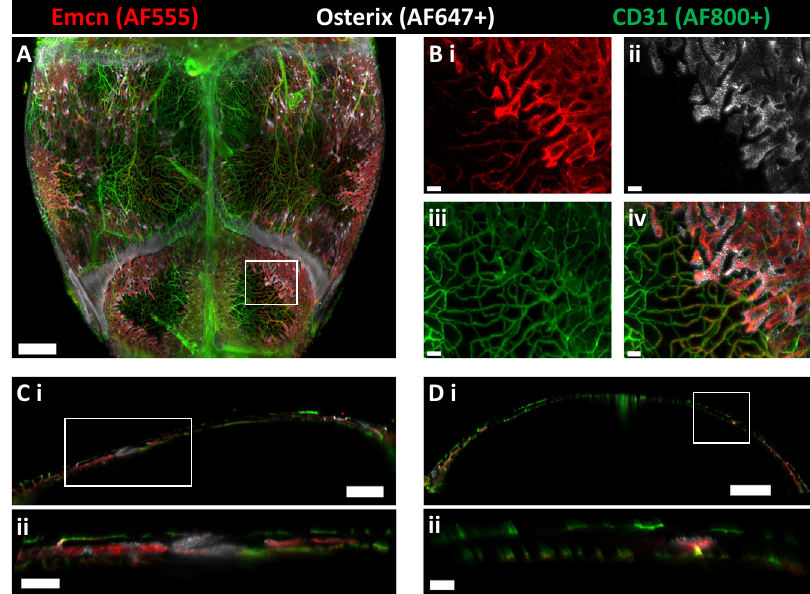
Fig. 1 3D light-sheet imaging of the murine calvarium at single-cell resolution. A Maximum intensity projection (MIP) of vessels and Osterix + skeletal progenitors in the parietal and posterior frontal bones of the calvarium. B Images from the boxed region in A demonstrating the high resolution and signal quality obtained in each channel (i – iv). The dyes used for each channel are designated above ( A ) and ( B ): AF555 for Endomucin (i), AF647 plus for Osterix (ii), and AF800 plus for CD31 (iii). C , D Sagittal ( C ) and frontal ( D ) 40- μ m-thick optical sections demonstrating the location of vessels and Osterix + cells along the thickness of the calvarium. Boxed regions from ( C i) and ( D i) are shown in C ii and D ii. Similar results were achieved for all the calvaria imaged in this study ( n = 45 calvaria). Scale bars: 1000 μ m ( A , D i), 800 μ m ( C i), 300 μ m ( C ii), 100 μ m ( B i – iv, D ii). Colors: Red: Endomucin (Emcn), Gray: Osterix, Green: